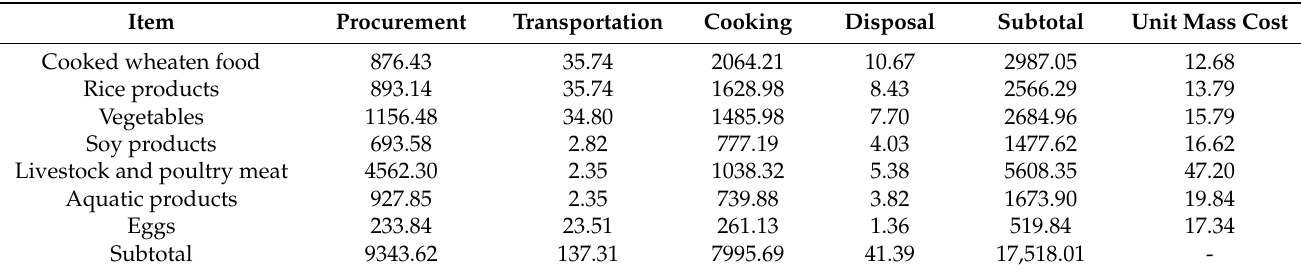
Table 6. Cost of food waste in university canteens (unit: